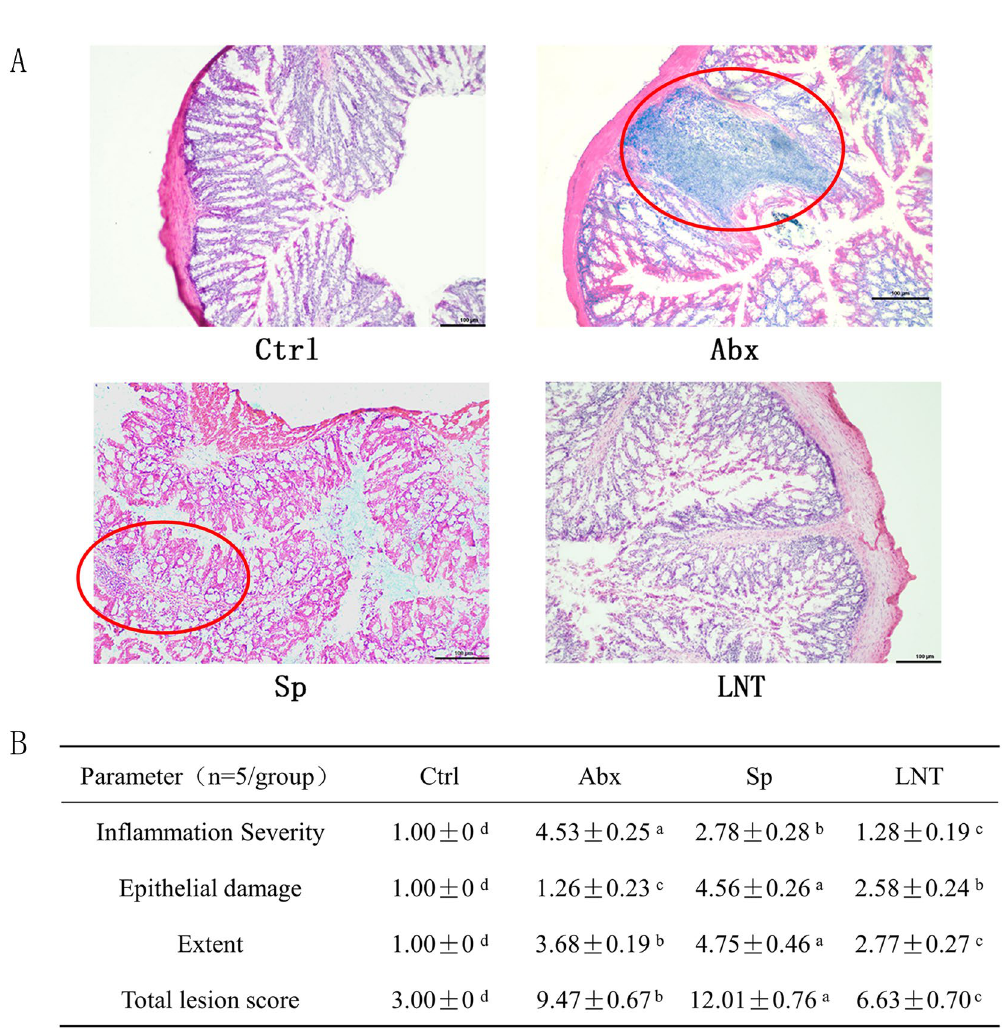
Figure 3. ( A ) Photomicrographs of hematoxylin and eosin (H&E)-stained colon tissue. Histopathological analysis of the colon tissue. The area of inflammation has been circled in red. Original magnification 100, Scale bar: 100 μm. ( B ) Effects of LNT on colon pathology of antibiotics-induced mice (n = 5/group). Values with different letters are significantly different ( p <